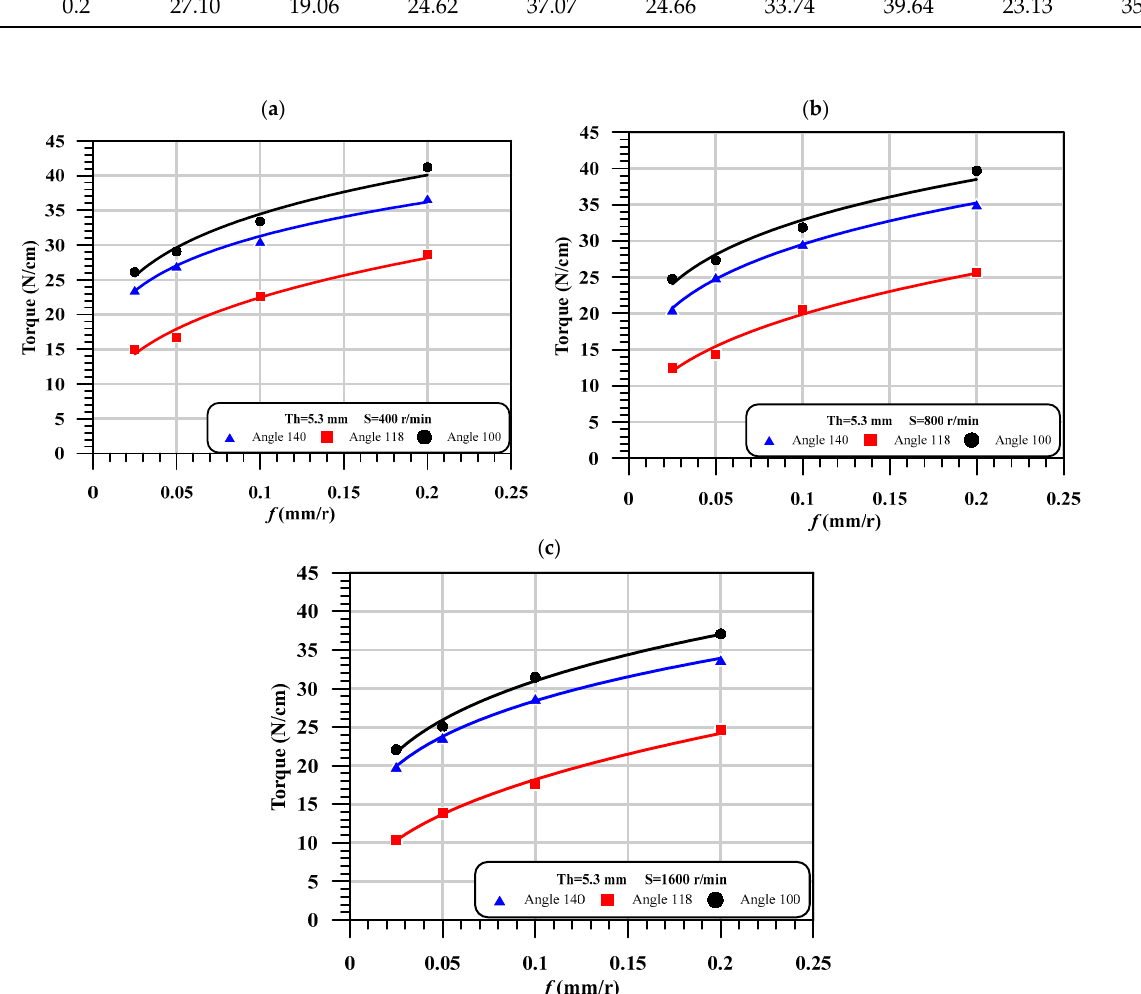
Figure 9. The effect of feed on the torque with different point angles at different speeds, ( a ) At thickness of 5.3 mm and Speed = 400. r/min; ( b ) At thickness of 5.3 mm and speed = 800 r/min; ( c ) At thickness of 5.3 mm and speed = 1600